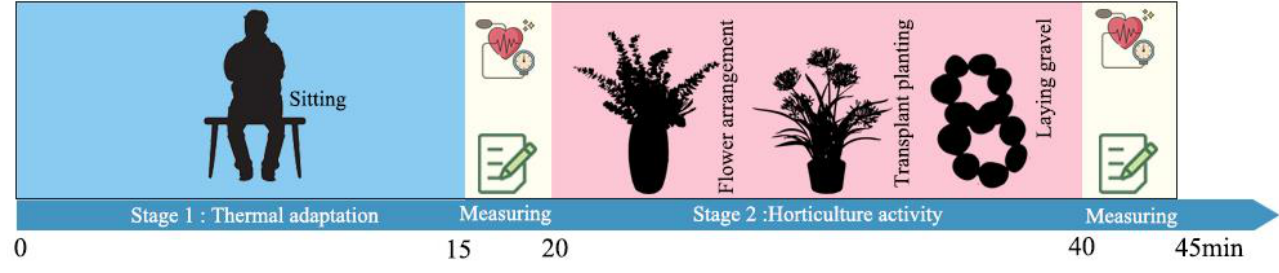
Figure 2. Details of the experimental procedure.